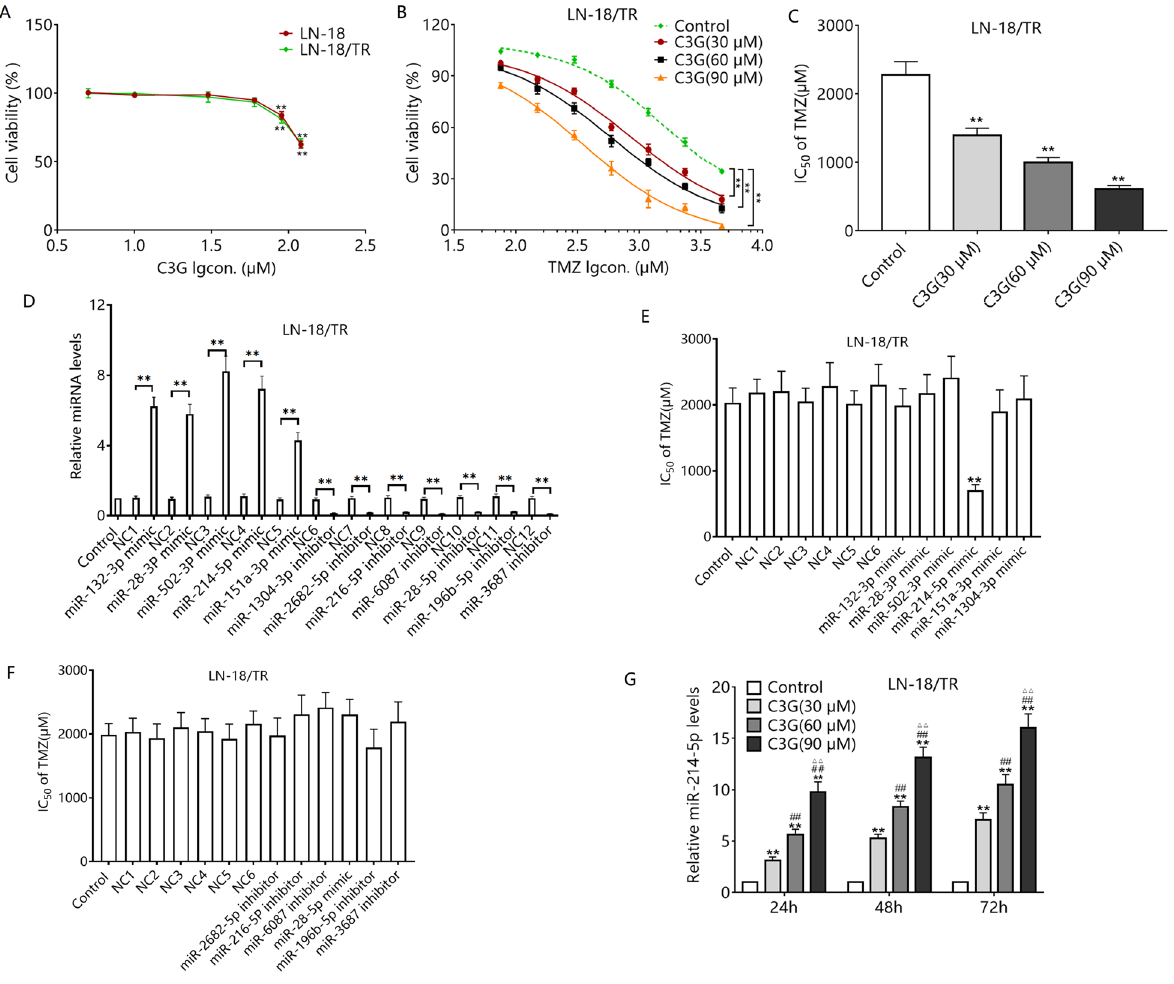
Figure 3. Cyanidin-3- O -glucoside (C3G) induces sensitization to temozolomide (TMZ) and the upregulation of miR-214-5p in LN-18/TR cells. ( A ) LN-18 and LN-18/TR cells were treated with C3G (5, 10, 30, 60, 90, and 120 μM) for 72 h, and the cell proliferation inhibition rate was detected by the MTT method. ( B ) LN-18 and LN-18/TR cells were treated with C3G (30, 60, and 90 μM) combined with TMZ (80, 160, 320, 640, 1280, and 2560 μM), and the cell proliferation inhibition rate was detected by the MTT method. ( C ) The IC 50 of TMZ in LN-18/TR cells treated with 30, 60, and 90 μM C3G. ( D ) LN-18/TR cells were transfected with mimics of miR- 132-3p, miR-28-3p, miR-502-3p, miR-214-5p, miR-151a-3p, and miR-1304-3p, or inhibitors of miR-2682-5p, miR-216-5p, miR-6087, miR-28-5p, miR-196b-5p, and miR-3687, and corresponding negative controls. The expression levels of each miRNA were detected using RT-FqPCR. ** P < 0.01. ( E ) IC50s of TMZ in LN-18/TR cells transfected with each miRNA mimic. ** P < 0.01 compared to NC4. ( F ) IC50s of TMZ in LN-18/TR cells transfected with each miRNA inhibitor. ( G ) LN-18/TR cells were treated with 30, 60, and 90 μM C3G, and the expression of miR-214-5p was assessed by RT-FqPCR. ** P < 0.01 compared to